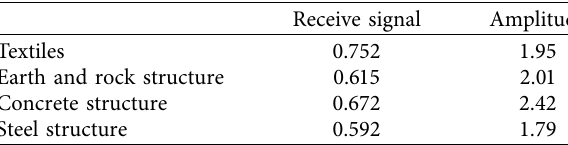
Table 2: Material parameter value.